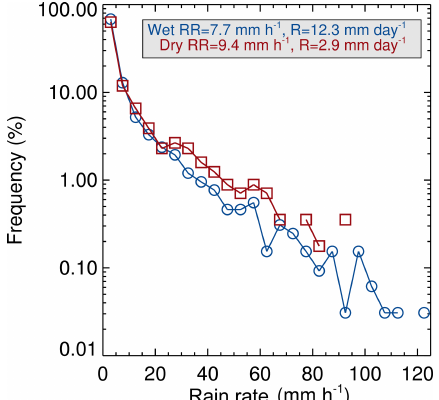
Figure 1. Rainfall rate (RR) histogram for wet and dry seasons computed using the T3 disdrometer. Wet and dry seasons occurred from January to March and August to October, respectively, for the years 2014 and 2015. Rainfall rate (RR) and total rainfall (R) are given in the